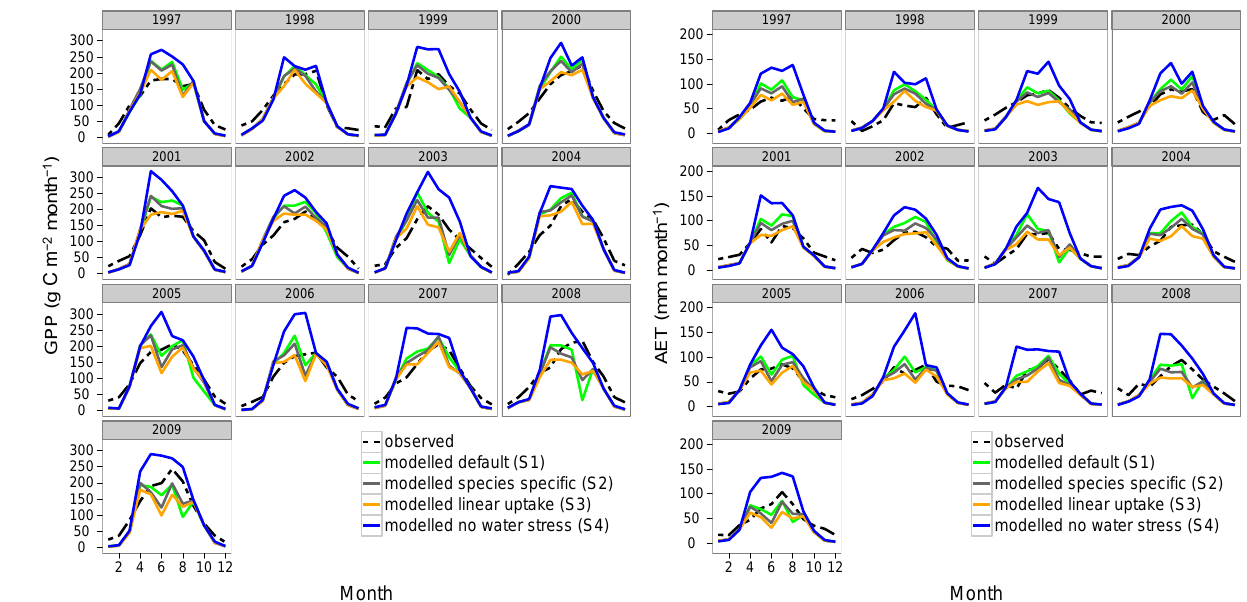
Figure 7. Comparison of fluxes for (a) GPP (gCm − 2 month − 1 ) and (b) AET (mmmonth − 1 ) using different water uptake functions. Dotted line: observed values. Solid lines: modelled values for scenarios